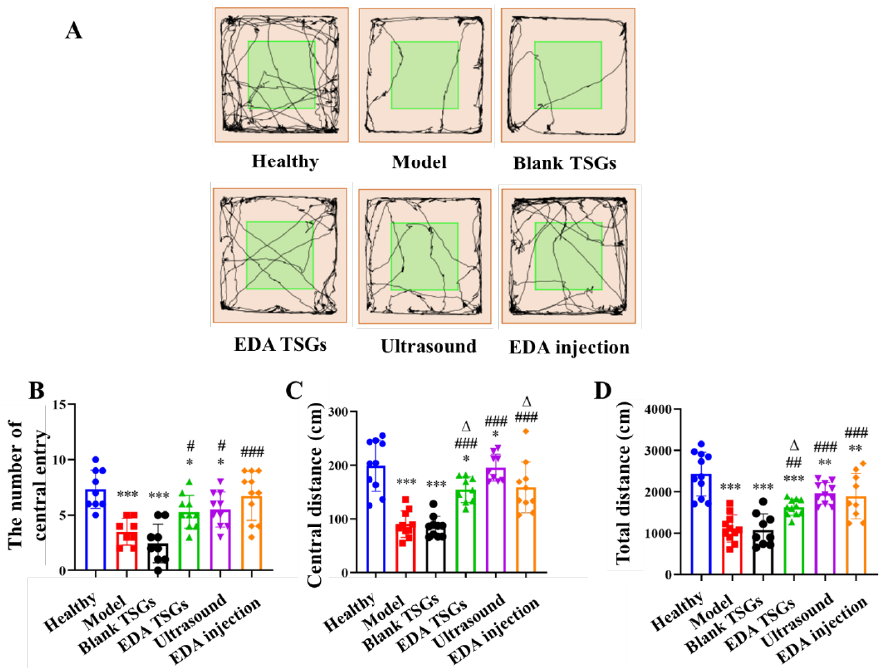
Figure 7. Comparison of spontaneous behavior, exploratory spirit and the mental tension of mice in each group by the open field test . The track map ( A ); Statistical data analysis of the number of central entry ( B ), central distance ( C ) and total distance ( D ). Data are represented as mean ± SD ( n = 10). * : means significant difference, vs. the healthy group, * p < 0.05, ** p < 0.01, *** p < 0.001; # : means significant difference, vs. the model group, # p < 0.05, ## p < 0.01, ### p < 0.001; Δ : means significant difference, vs. the ultrasound group, Δ p < 0.05.